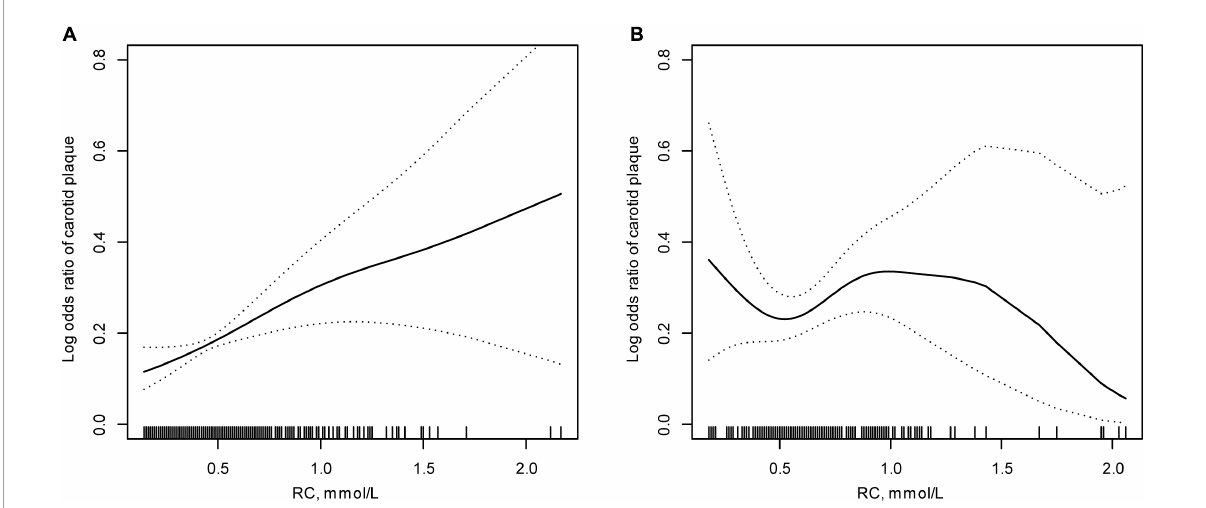
FIGURE2 Effect of new-onset carotid plaque based on remnant lipoprotein cholesterol (RC) modified by low-density lipoprotein cholesterol (LDL-C) levels*. (A) Baseline LDL-C < 3.4 mmol/L; (B) baseline LDL-C ≥ 3.4 mmol/L. *Adjusted for: sex, age, body mass index, current drinking, current smoking, estimated glomerular filtration rate, diabetes mellitus, hypertension, antihypertensive, and hypoglycemic drugs.